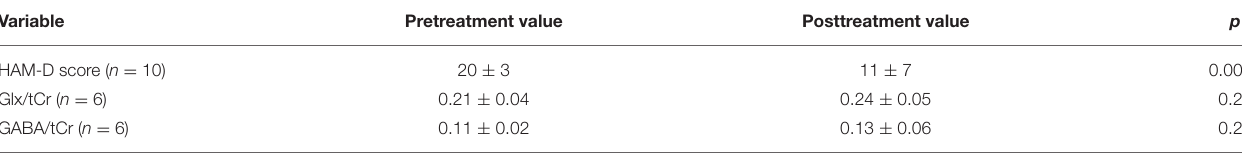
TABLE 1 | Depression ratings, Glx and GABA levels before and after rTMS treatment.